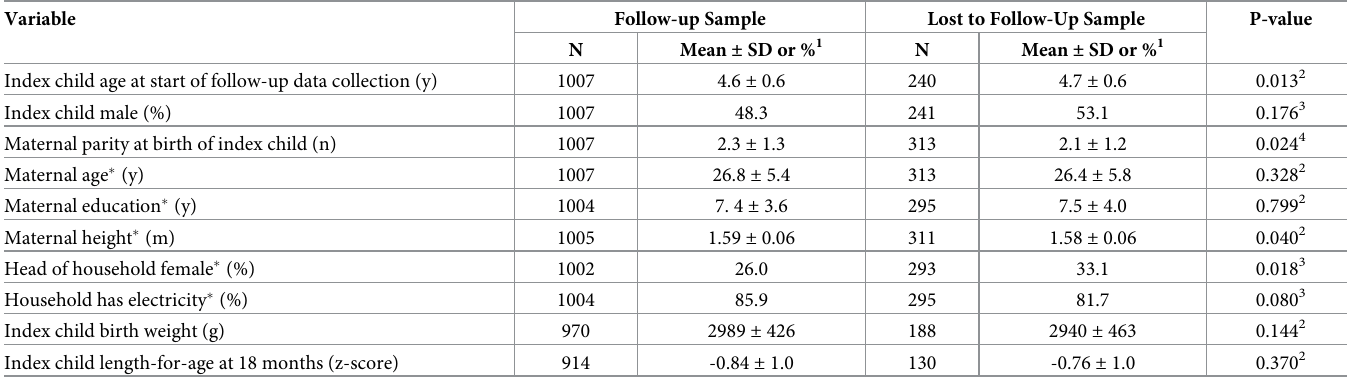
Table 1. Characteristics of follow-up and lost to follow-up samples.